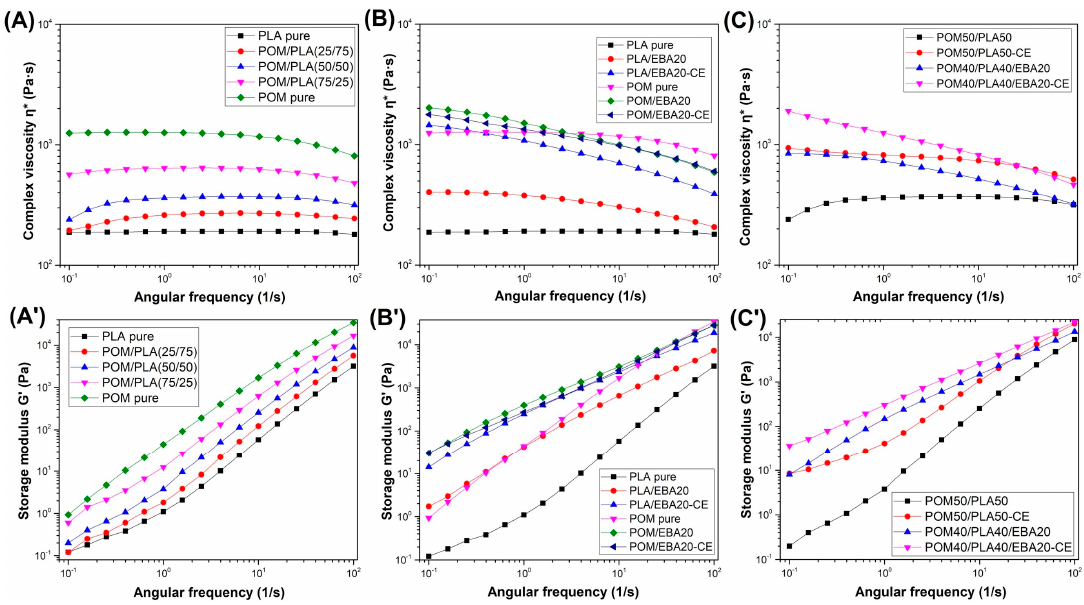
Figure 5. Complex viscosity and storage modulus of unmodified POM/PLA blends ( A , A’ ), EBA/CE- modified POM and PLA ( B , B’ ), and modified POM50/PLA50 ( C , C’ )